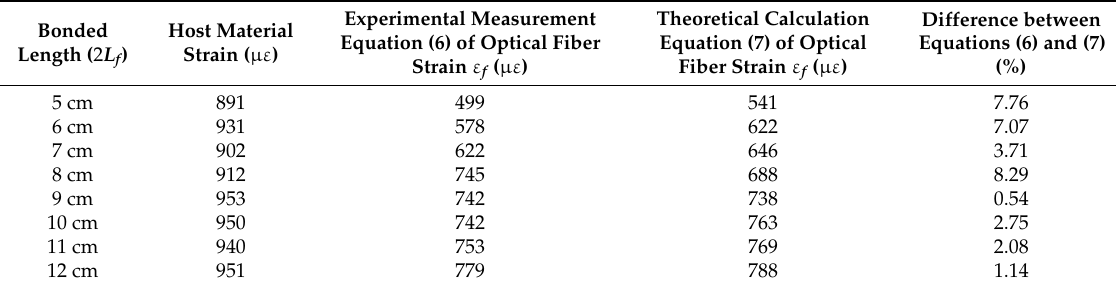
Table 3. Average strain of the optical fiber obtained by the experimental measurement Equation (6) and theoretical calculation Equation (7) with epoxy adhesive.